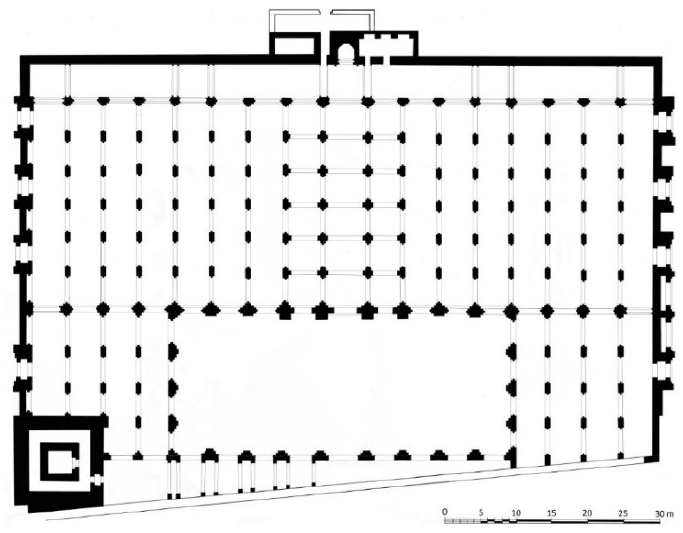
Figure 7. Floor plan of the second Kutubiyya of Marrakech. Drawing made by author.